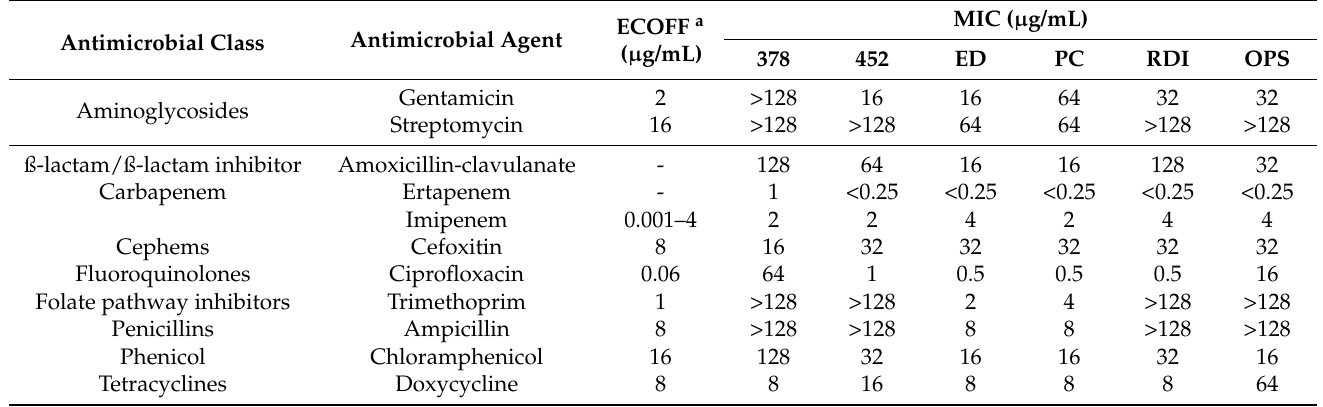
Table 1. MIC for E. coli bacterial strains. MICs of seven bacterial strains were tested against 18 different types of antibiotics. Breakpoints used for testing E. coli strains were adopted from EUCAST. ECOFF a Antimicrobial Class Antimicrobial Agent